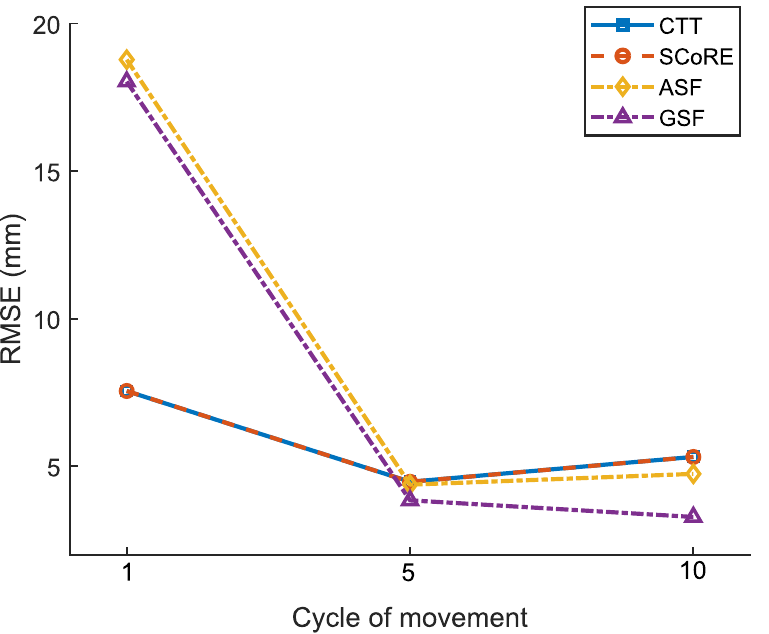
Fig 3. CoR localisation error (RMSE) for functional methods with varying the cycle of movement. Results showed that the accuracy of CoR estimate was significantly improved by increasing the cycle of movement from 1 and 5. The data is relative to fast and normal